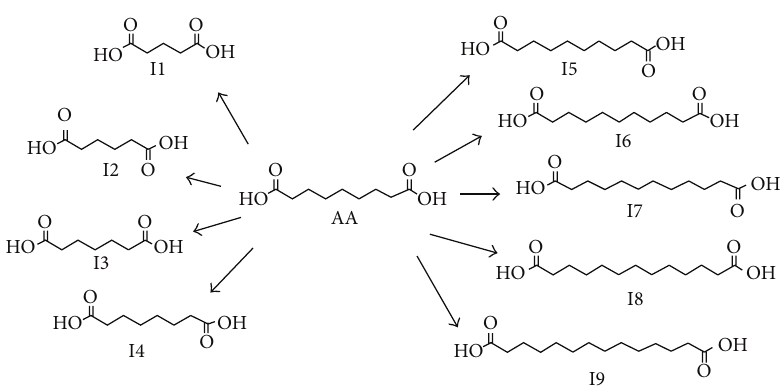
Figure 2: Known impurities of azelaic acid (AA)—dicarboxylic acids (I1–I9).